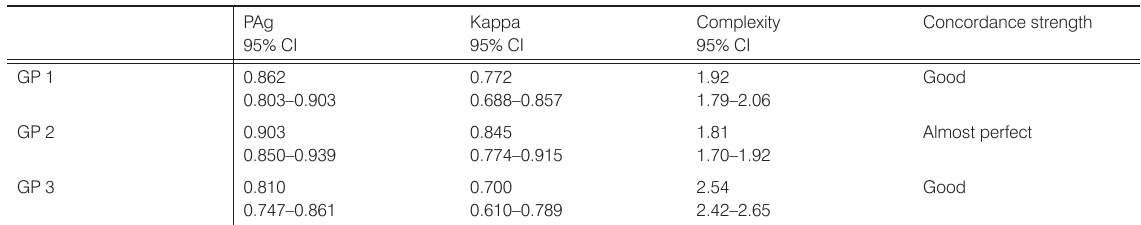
Table 1. Proportion of agreement (PAg) and weighted Kappa with confidence intervals of 95% (95% CI) for ECG readings by GP in comparison with cardiologist reading after codification by Novacode in normal /minor or major abnormalities.